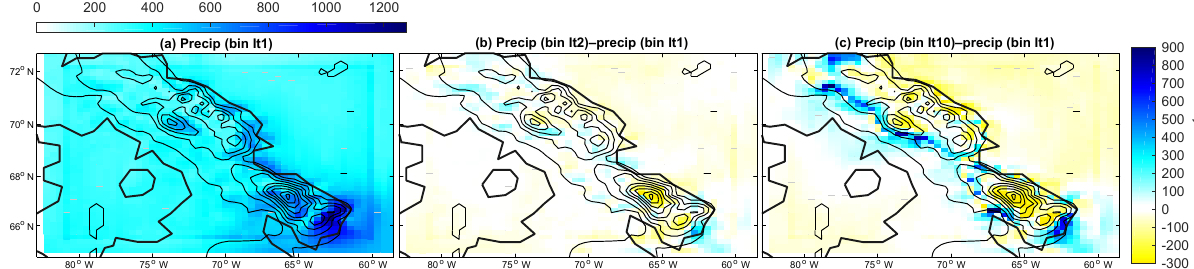
Figure 6. Annual precipitation in WRF in select iterations: (a) the precipitation in the Iteration 1 WRF run. Precipitation differences between Iteration 1 and the (b) second and (c) last iterations.